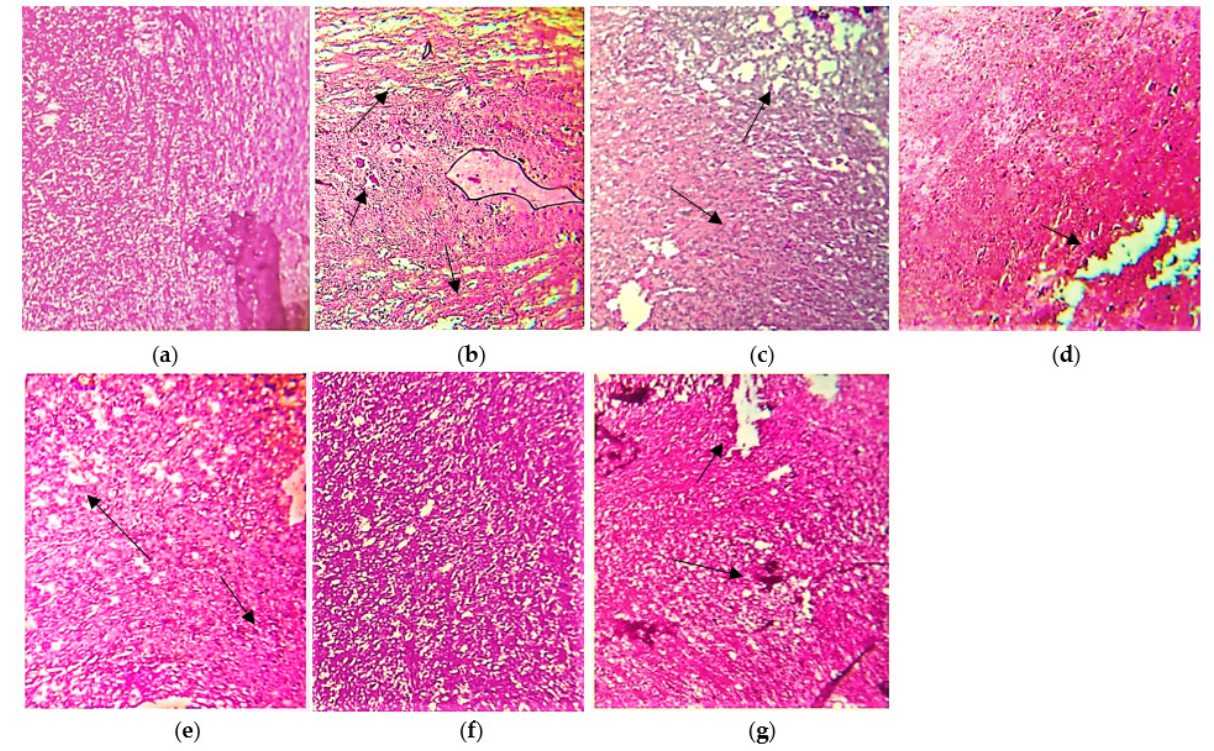
Figure 9. Histopathological outcomes of spinal cord tissues: ( a ) normal control group rat, ( b ) LPS intoxicated rat spinal cord tissues, ( c ) N. hindustana extract-treated group, ( d ) V. negundo treated group, ( e ) A. albiflora ethanolic extract-treated group, ( f ) conjugation of N. hindustana , V. negundo , and A. albiflora treated group, ( g ) brain section of the standard drug group. Objective size is 40×. Arrows represent pronounced hypercellular lesions due to inflammatory cells infiltration and de- myelination.